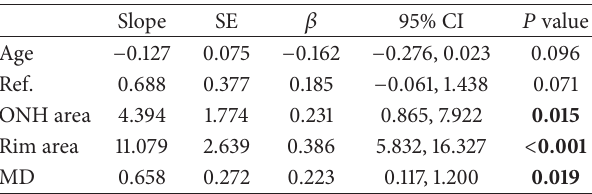
Table 4: Multiple regression analysis for the relationship between the cpRNFL thickness and other factors.